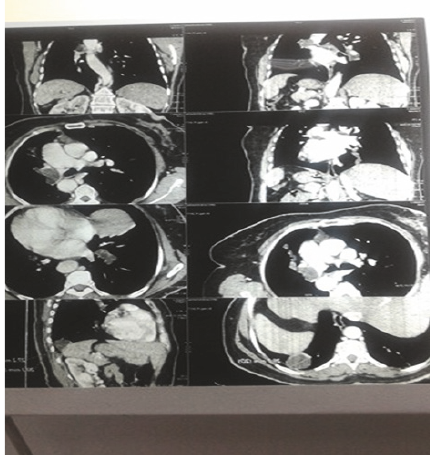
Figure 4: CT chest scan with a 31 cm dilation of the pulmonary trunk with a partial occlusion of the left pulmonary artery and a complete occlusion of the right pulmonary artery by a fluid atten- uation lesion and a subpleural cyst of the inferior lungular segment measuring 19